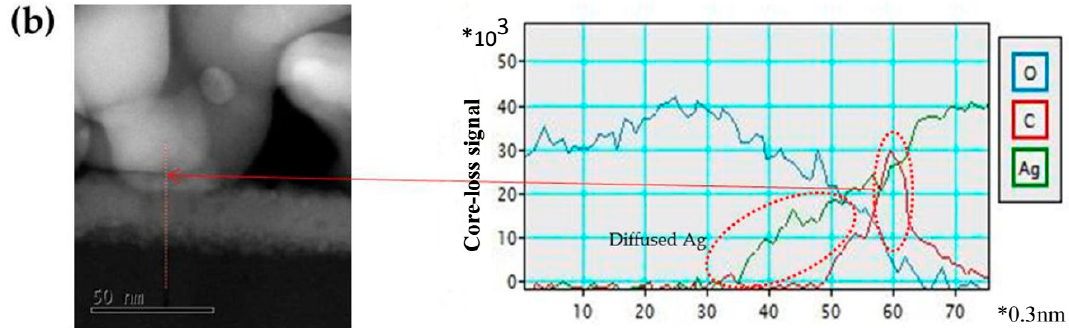
Figure 5. EELS line scanning of a-IGZO/Ag interfaces with printed substrate temperature at ( a ) room temperature and ( b ) 60 °C; the x axis step size of the right pictures is 0.3 nm.